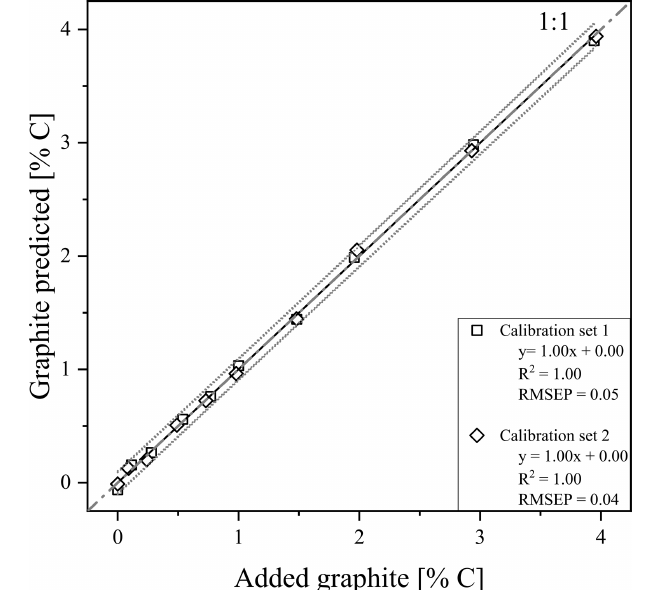
Figure 3. Prediction plots after thermogravimetric analysis (TGA) of calibration set 1 (squares) and 2 (diamonds). 95% predictions band (dotted grey) are displayed besides the linear regression line (black). Graphite was added in the concentrations between 0% and 4.0% graphite as indicated in Table 1.